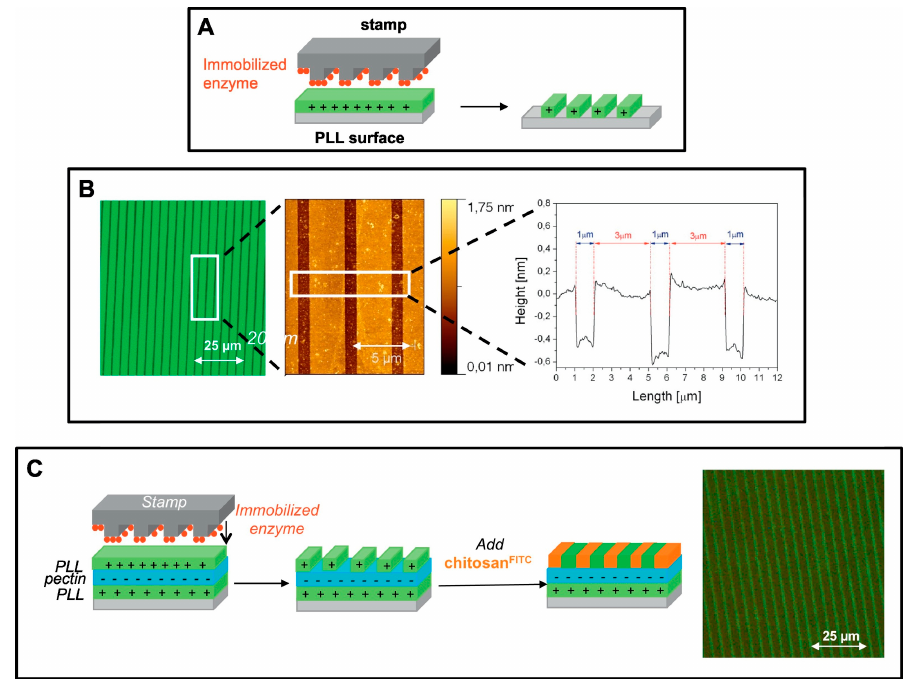
Figure 8. Nanosensing application in food packaging. Schematic representation of the enzymatic microlithography process with ( B ) the resulting Atomic Force Microscopy (AFM) topographic image of the patterned Poly-L-Lysine (PLL) surface (scale: 5 µm) and line profile of the corresponding AFM image. ( C ) Patterning process of multilayered thin films composed of pectin and PLL. When the stamp is applied on the film, only the top layer is patterned, which allows the formation of alternate positive and negative lines highlighted by further site-selective adsorption of cationic polymer [93].